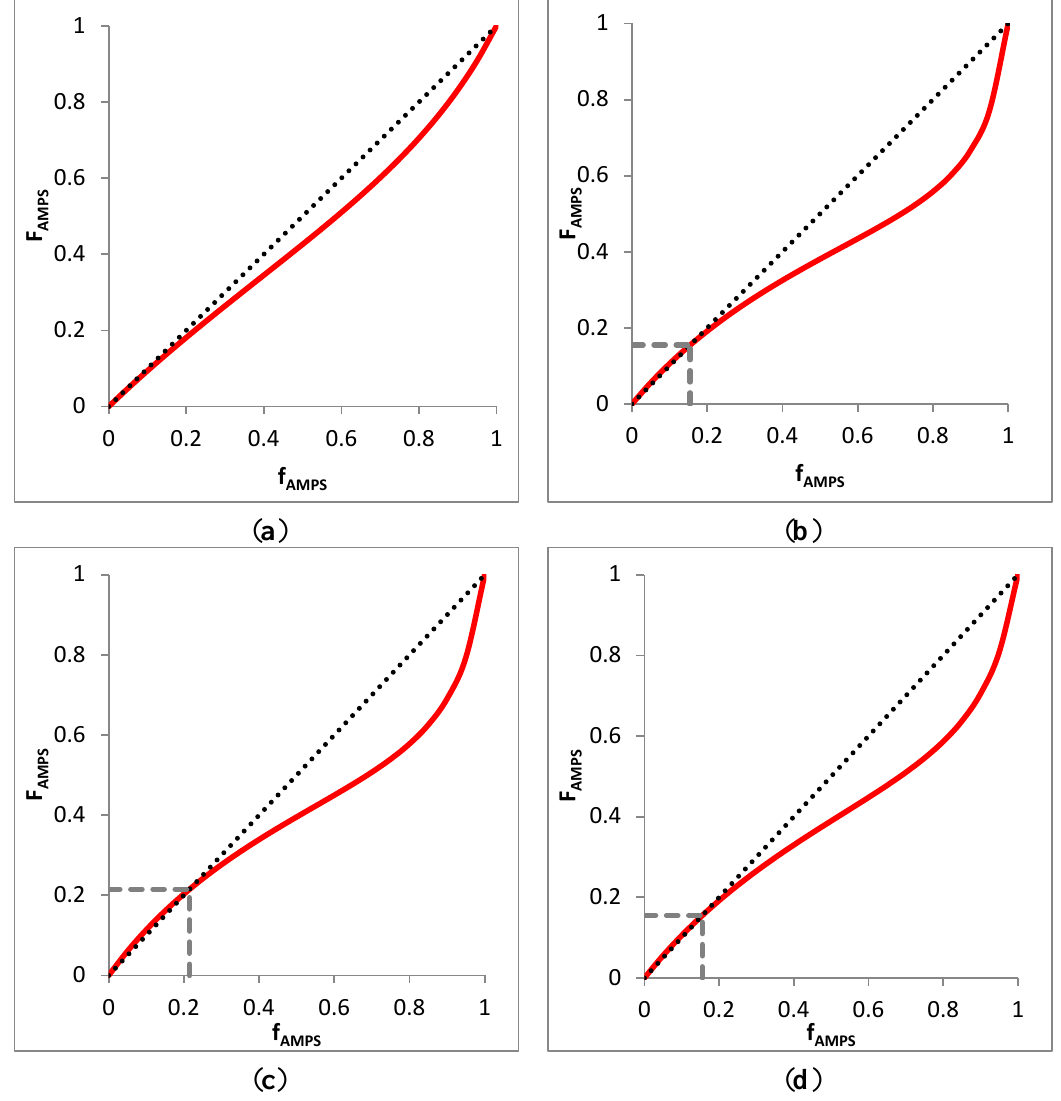
Figure 4. Determination of azeotropic composition from ( a ) literature data [26]; ( b ) preliminary data; ( c ) T-M-designed data; and ( d ) EVM-designed data; 45° line (F